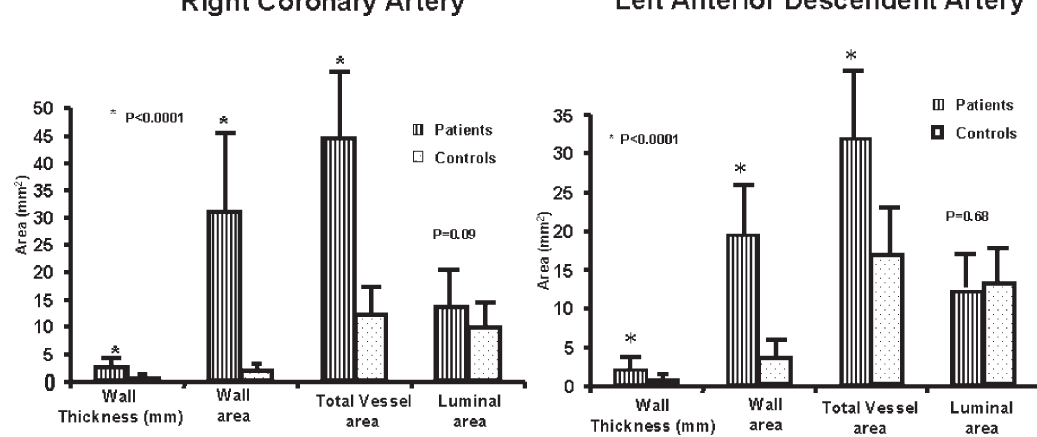
Figure 3a - Magnetic resonance of coronary arteries. Positive remodeling of coronary arteries indicated by increased wall thickness, wall area, and total vessel area with preservation of luminal area 104